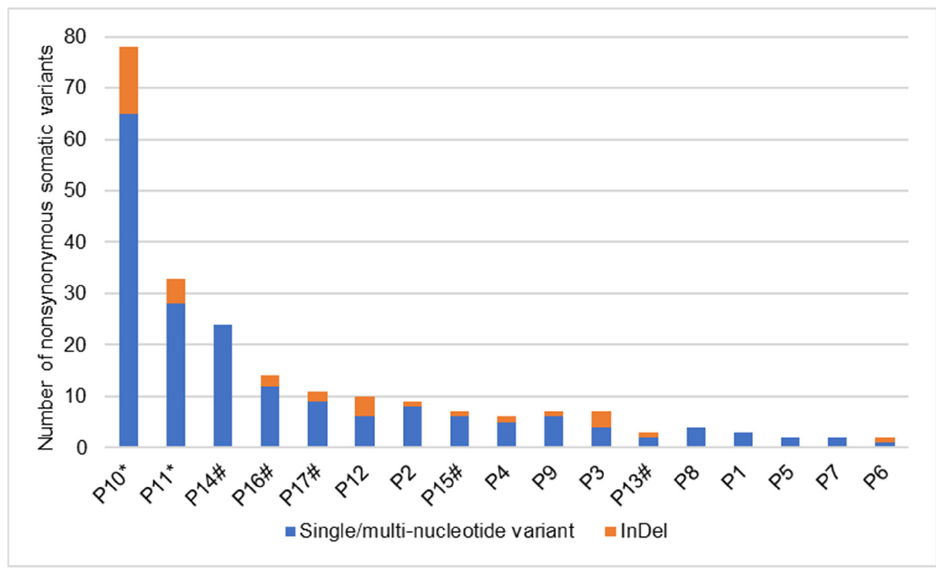
Figure 1. Number of nonsynonymous somatic variants detected in 17 cases with primary Sjogren’s syndrome related extranodal marginal zone lymphoma of mucosa-associated lymphoid tissue. The vertical axis represents the number of somatic variants. The horizontal axis represents the cases, showing 12 cases with a matched blood sample and 5 cases without a matched blood sample. (* relapsed outside of the salivary gland, # cases without a matched blood sample) .